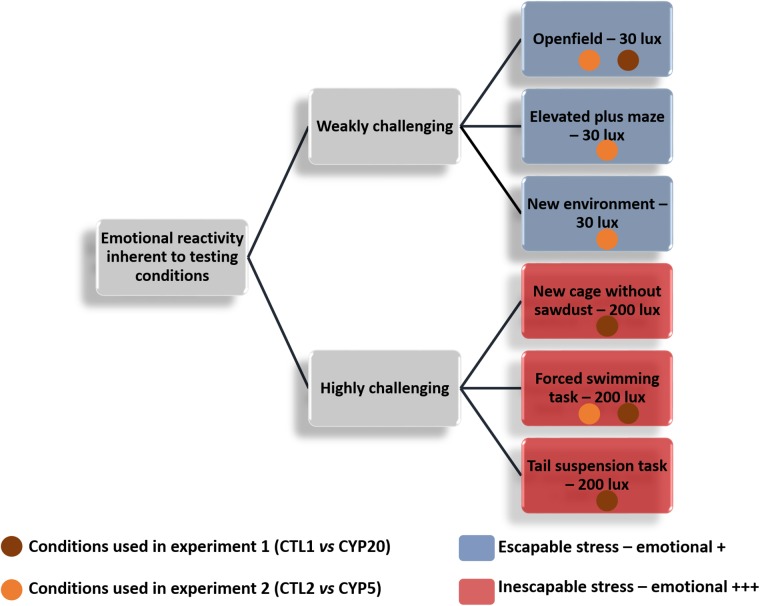
Behavioral tests used in the two experiments.Control and CYP-exposed offspring were exposed to both weakly and highly emotionally challenging environments. Conditions were defined as weakly challenging when the animals could escape from the stress generated by the apparatus and luminosity was low (no more than 30 lux). On the contrary, conditions were defined as highly challenging when the animals were not able to escape from the stress generated by the apparatus and luminosity was high (200 lux). The orange circles show the conditions for the CYP5-exposed offspring while the brown circles show the conditions for the CYP20-exposed offspring.